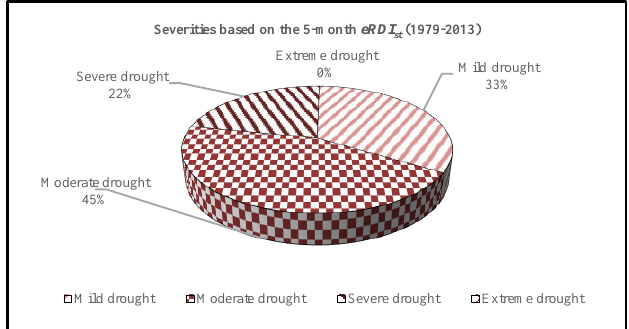
Figure 3: Pie chart of Severity of Historical agricultural droughts in Gourma based on the 5-month eRDIst. The Severe drought category is harshest severity level ever experienced in the study area while no extreme drought has manifested.